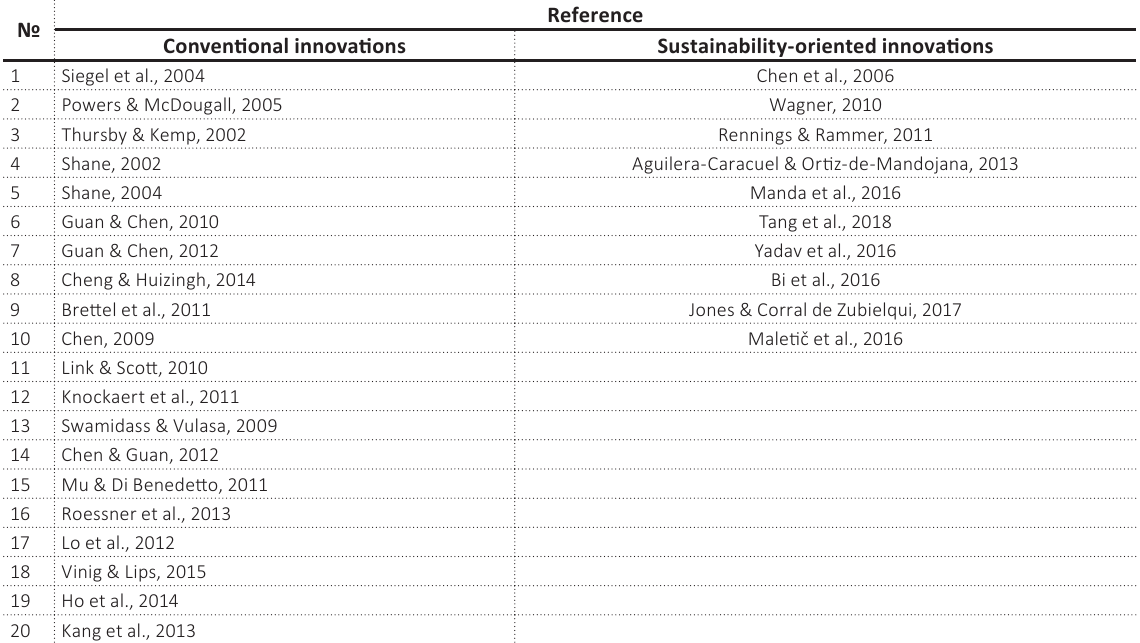
Table 1A. List of papers selected for content